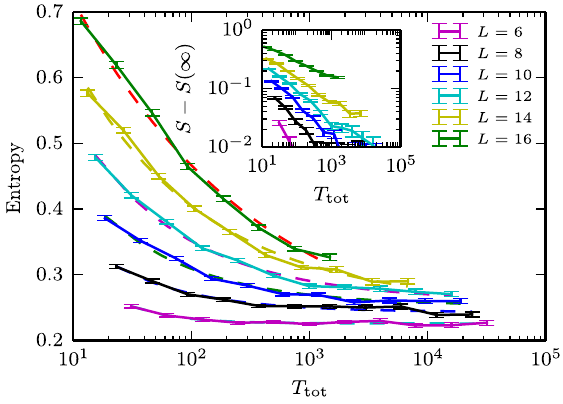
FIG. 6. Entanglement entropy at the center of the system. Dashed lines indicate a fit to S ¼ S 0 þ aT − b fit parameters. Inset: S ð T been obtained from the dashed fit in the main panel, on a double- logarithmic scale.